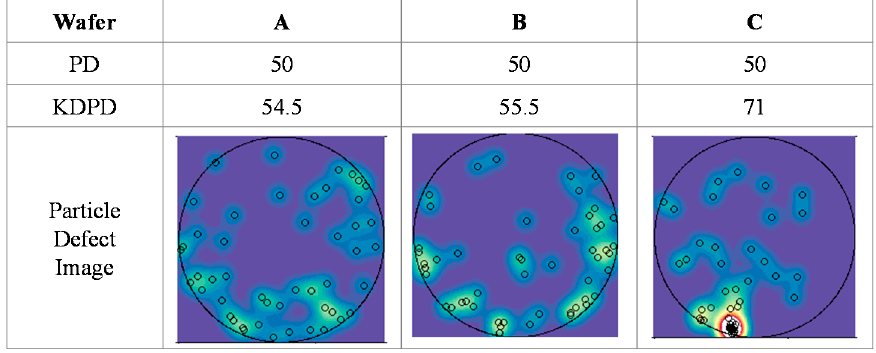
Figure 9. Comparative particle defect (PD) and kernel-density-based particle defect (KDPD).